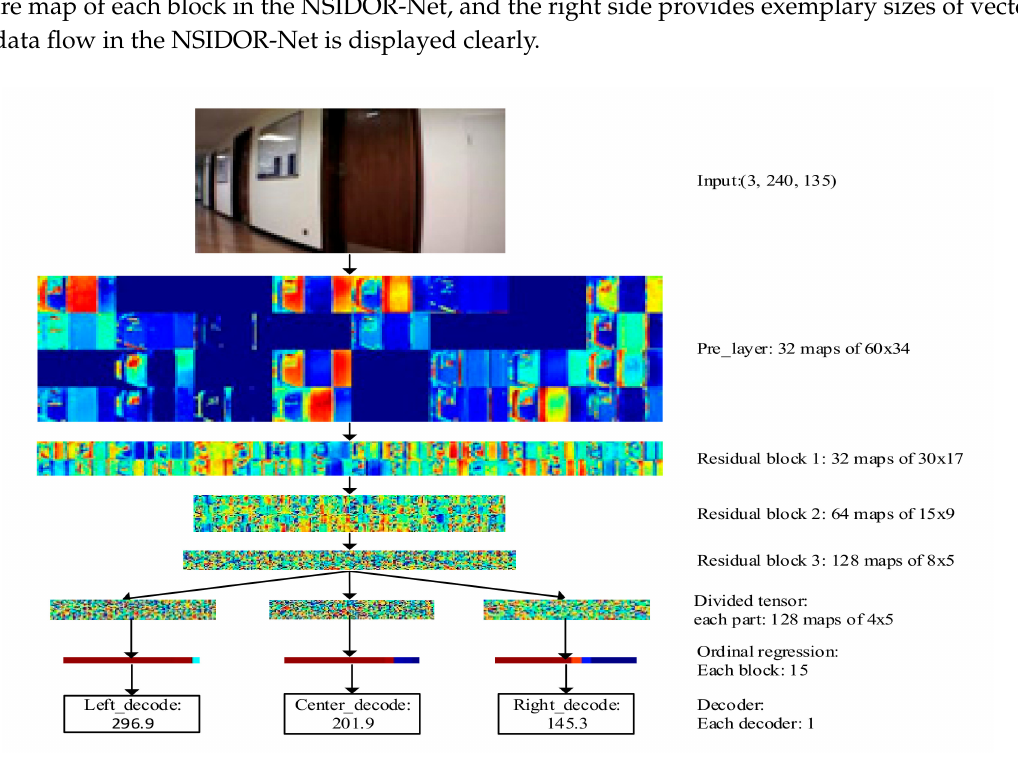
Figure 5. Intermediate visualization of